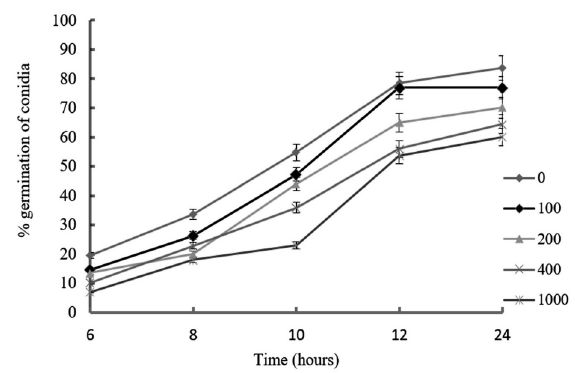
Figure 3: Antifungal effect of potassium silicate (Kasil®) on germination of conidia of C.acutatum Table 3: Effect of potassium silicate soil-drench treatments (200mg/l) on severity and anthracnose disease incidence in challenge inoculated C. annum (cv. HYW) with C. accutatum .